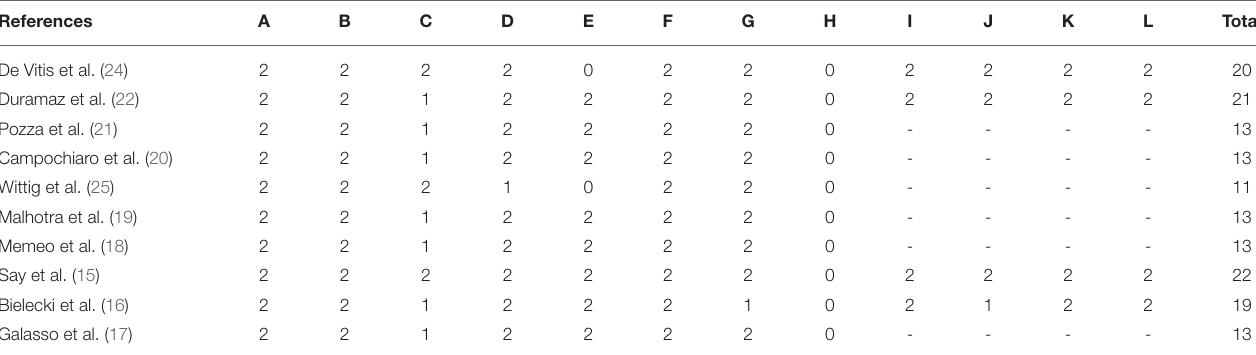
TABLE 4 | Summary of the risk of bias assessment for nonrandomized studies with the MINORS (Methodological Index for Non-Randomized Studies)